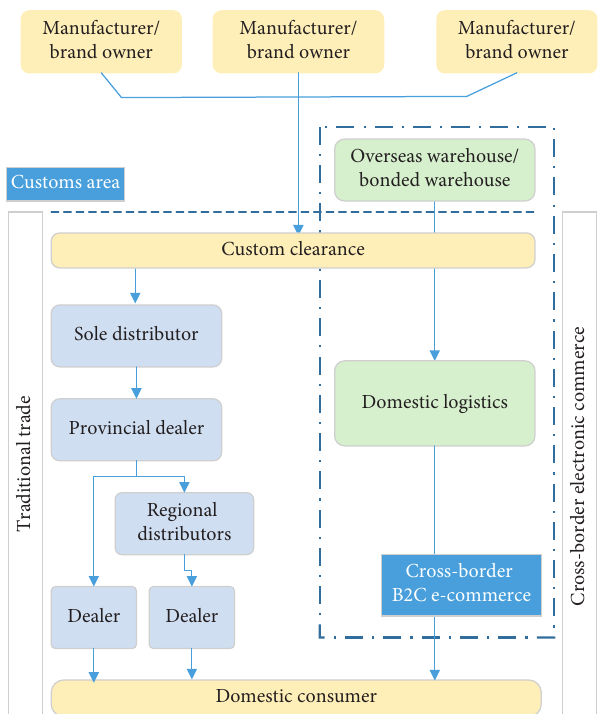
Figure 7: Supply chain difference between cross-border e-com- merce and traditional